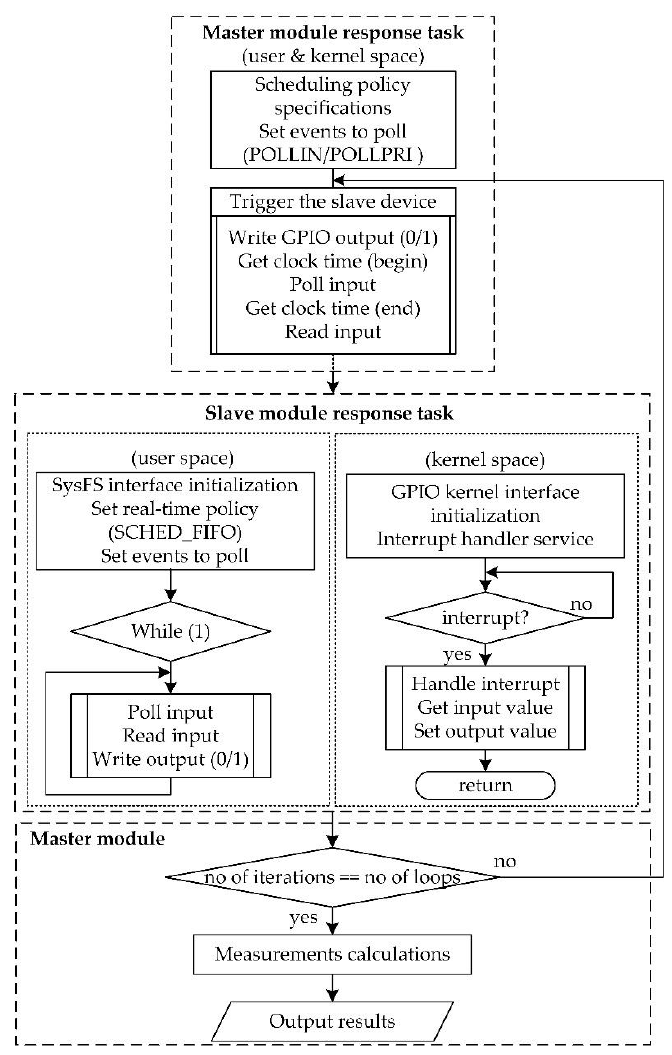
Figure 5. User and kernel space response task measurement algorithm.